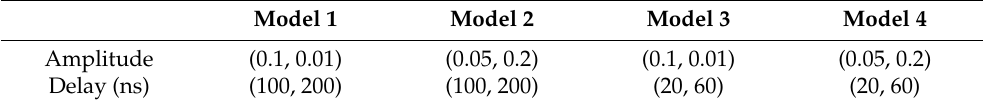
Table 4. Four multipath models.